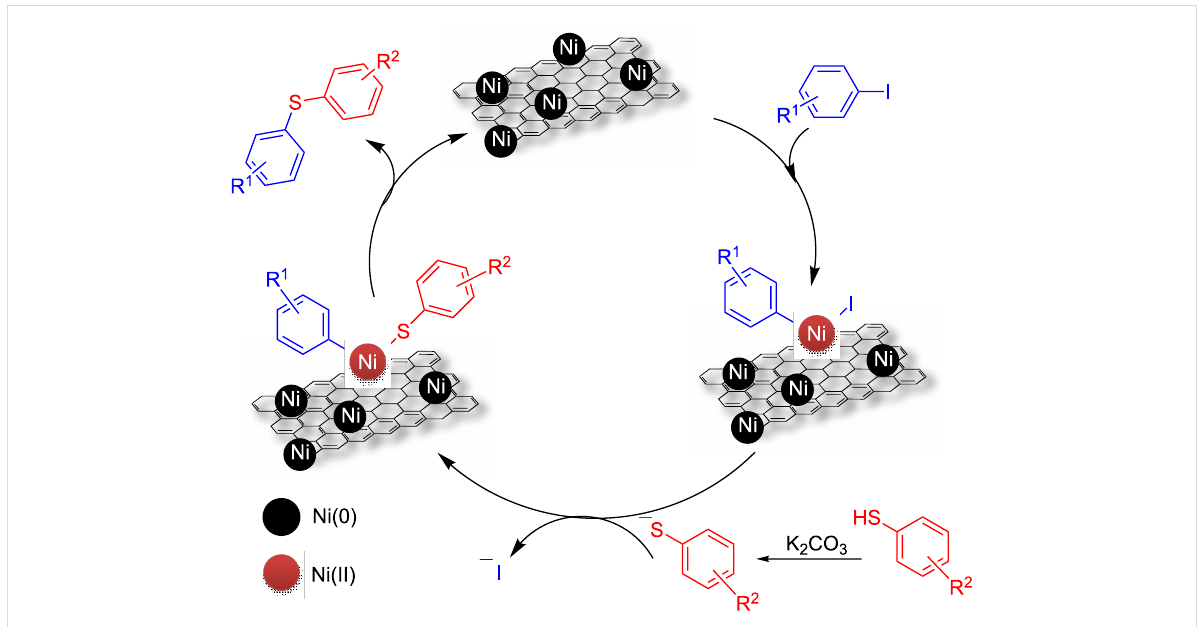
Figure 6: Proposed mechanism for the RGO-supported Ni-catalyzed C–S cross-coupling reaction.